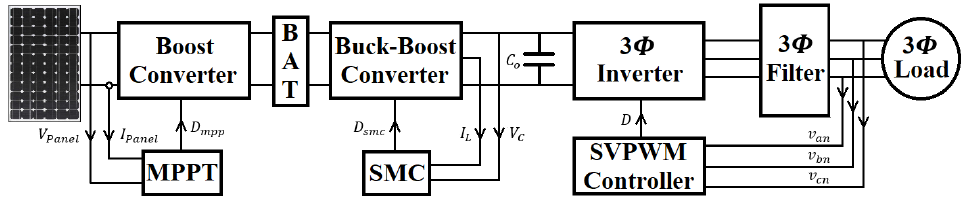
Figure 1. Overall photovoltaic energy conversion system block diagram.